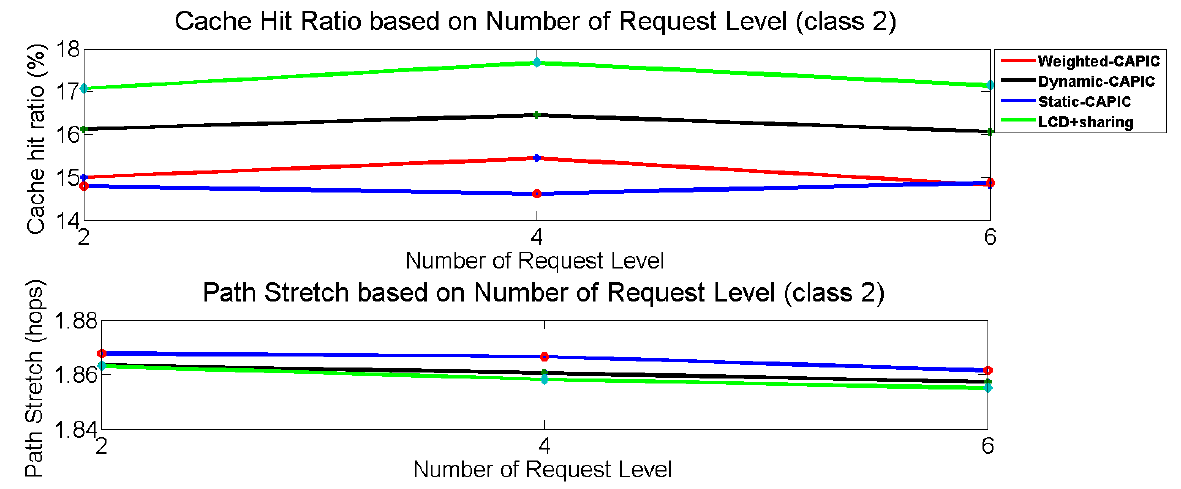
Figure 3. Cache hit ratio and path stretch of class 2 for various level of request.